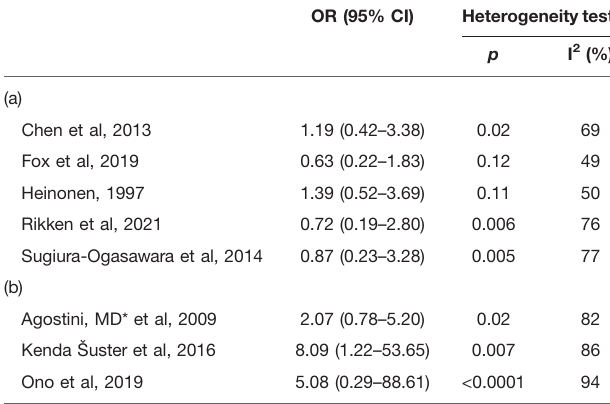
TABLE 1 | Outcomes for sensitivity analysis of included studies evaluating caesarean section.